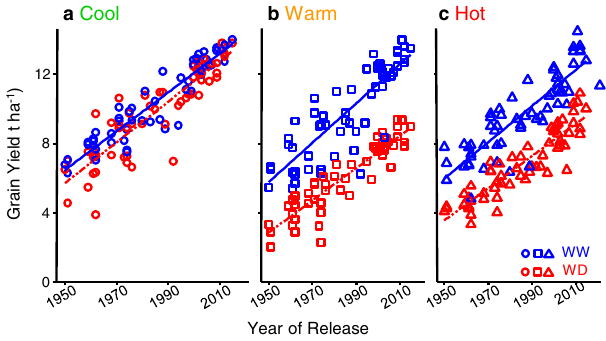
Fig. 2 The genetic gain of yield was similar in all studied environmental